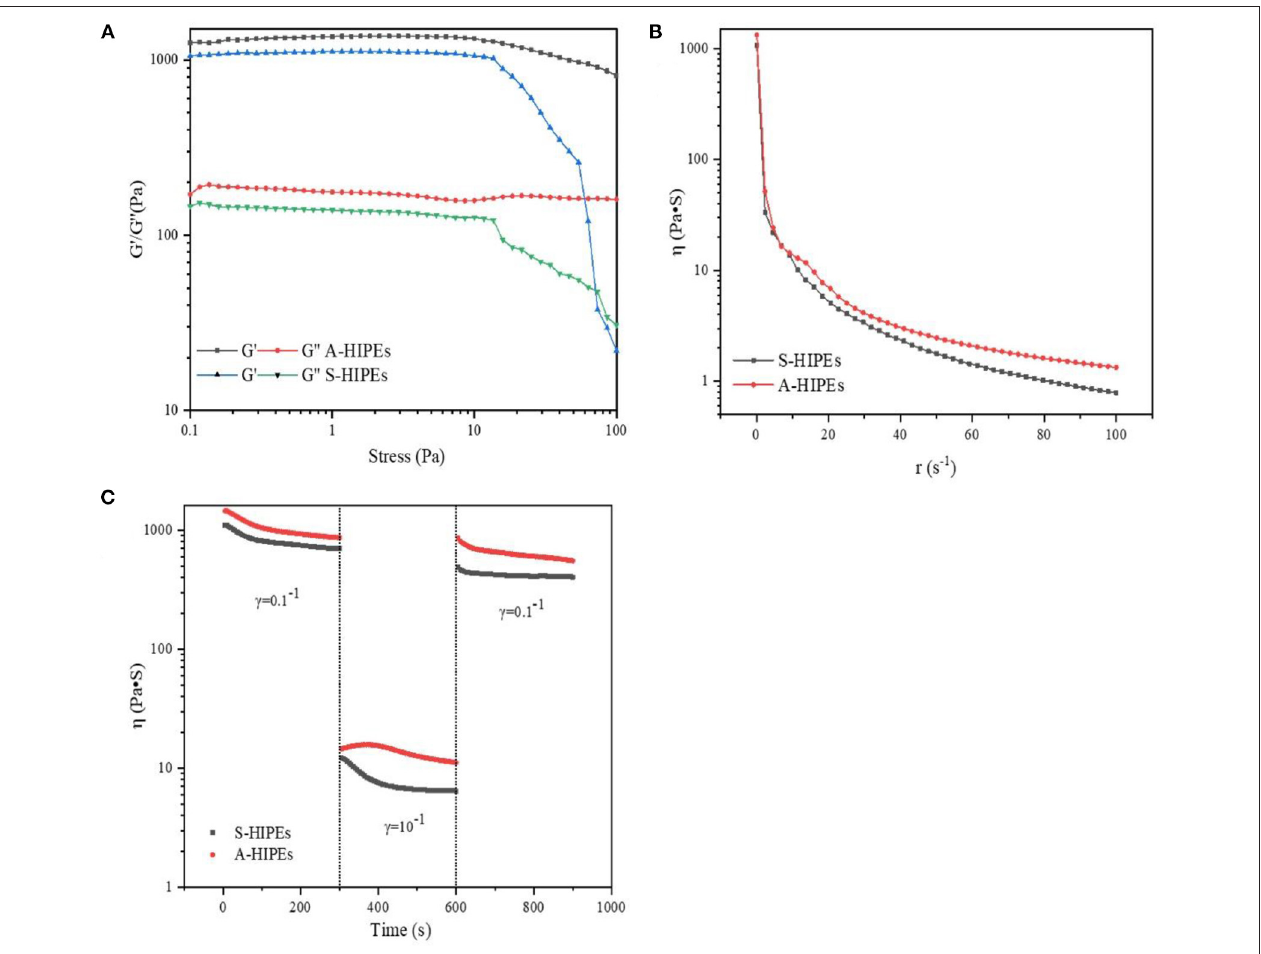
FIGURE 5 | Stress sweeps (A) , apparent viscosity (B) , and thixotropic recovery (C) for HIPEs stabilized by BCNs/SPI colloidal particles with different self-assembly